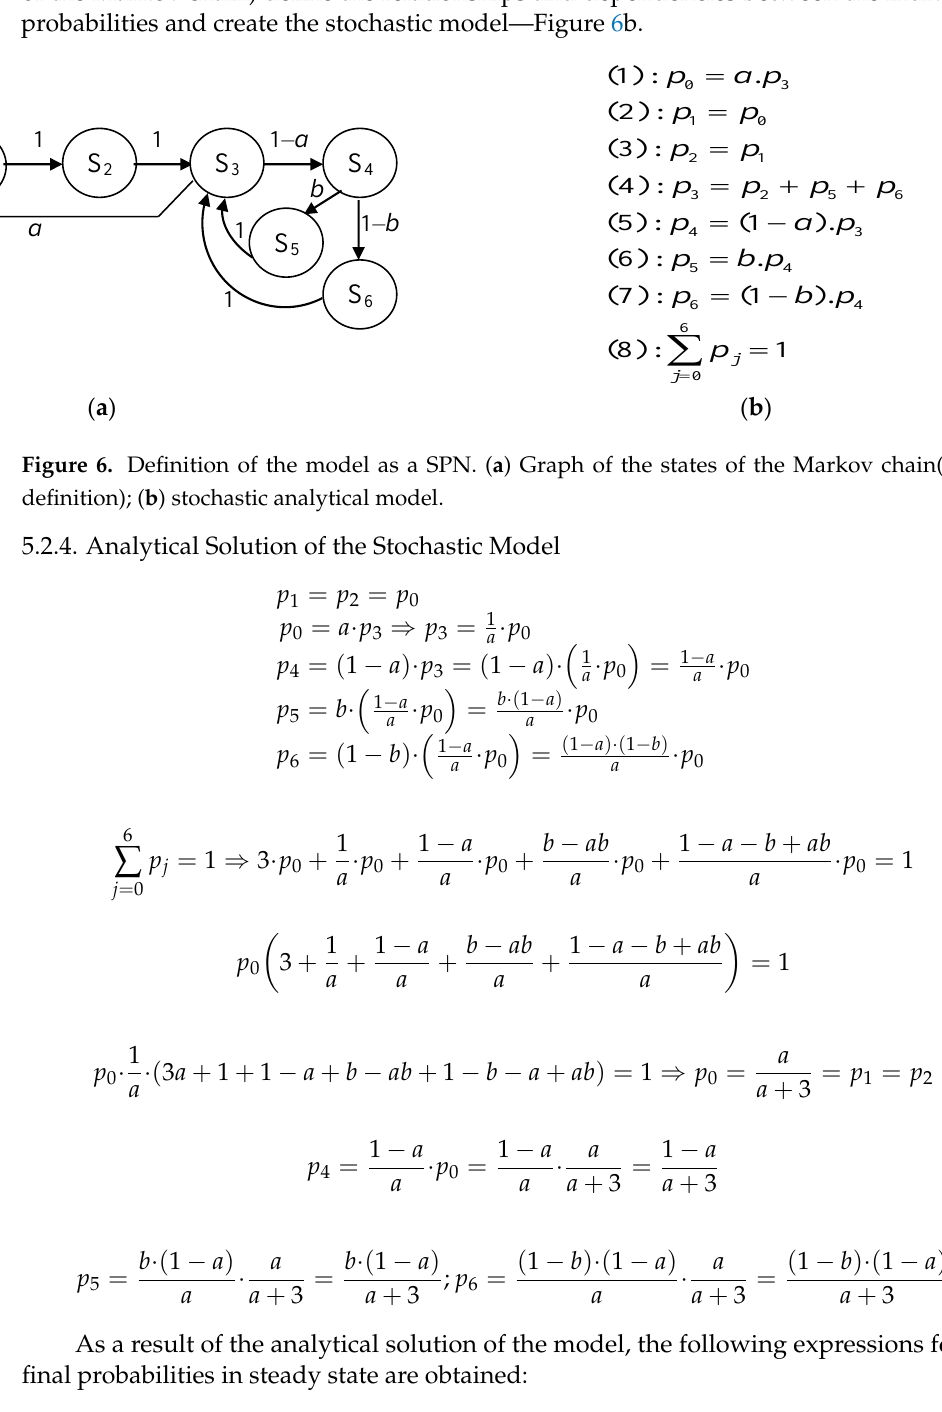
Figure 5. Matrix of transition probabilities